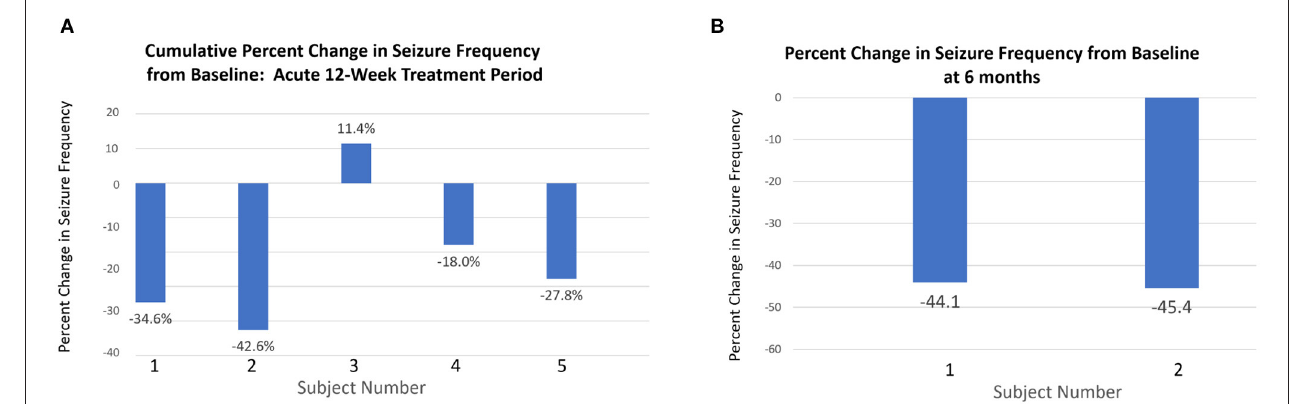
FIGURE 2 | Changes in seizure frequency at 12 weeks and 6 months. (A) Percentage change in total seizure frequency at 12 weeks relative to baseline for all patients. (B) Two subjects (1 and 2) who continued with the intervention for 6 months showed greater percentage reduction in seizure frequency from baseline to 6 months than at 12